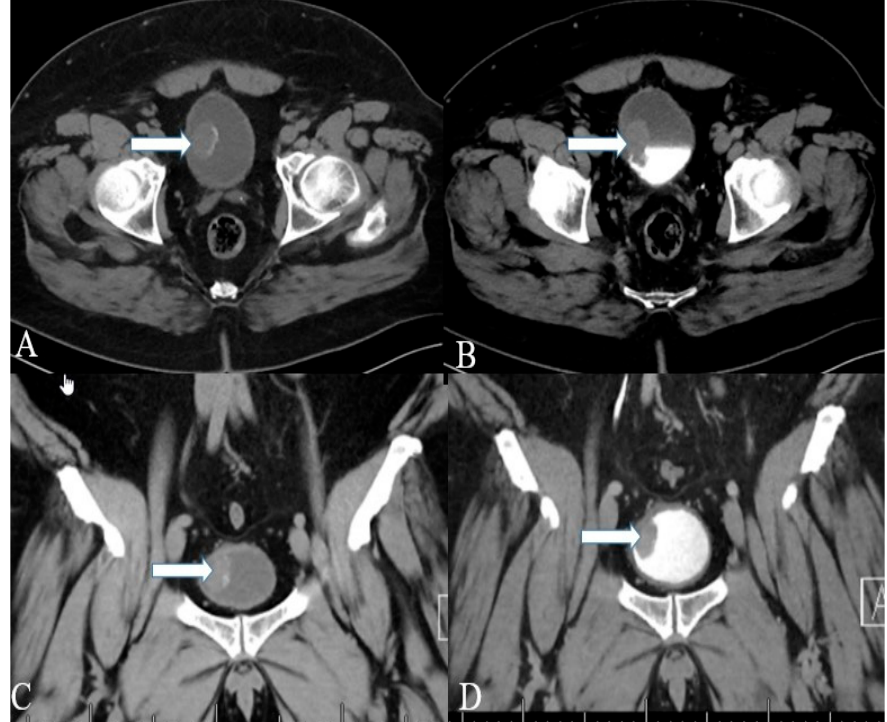
Figure 8. A 40-year-old female with urinary bladder NEN. Axial CT ( A ) pre-contrast and ( B ) delayed post-contrast images with coronal reconstruction ( C ) pre-contrast and ( D ) post-contrast reveal a 4.8 × 2.5 cm mass (arrows) at the proper aspect of the urinary bladder, showing faint peripheral calcification. Pathology revealed a neuroendocrine tumor of the urinary bladder.